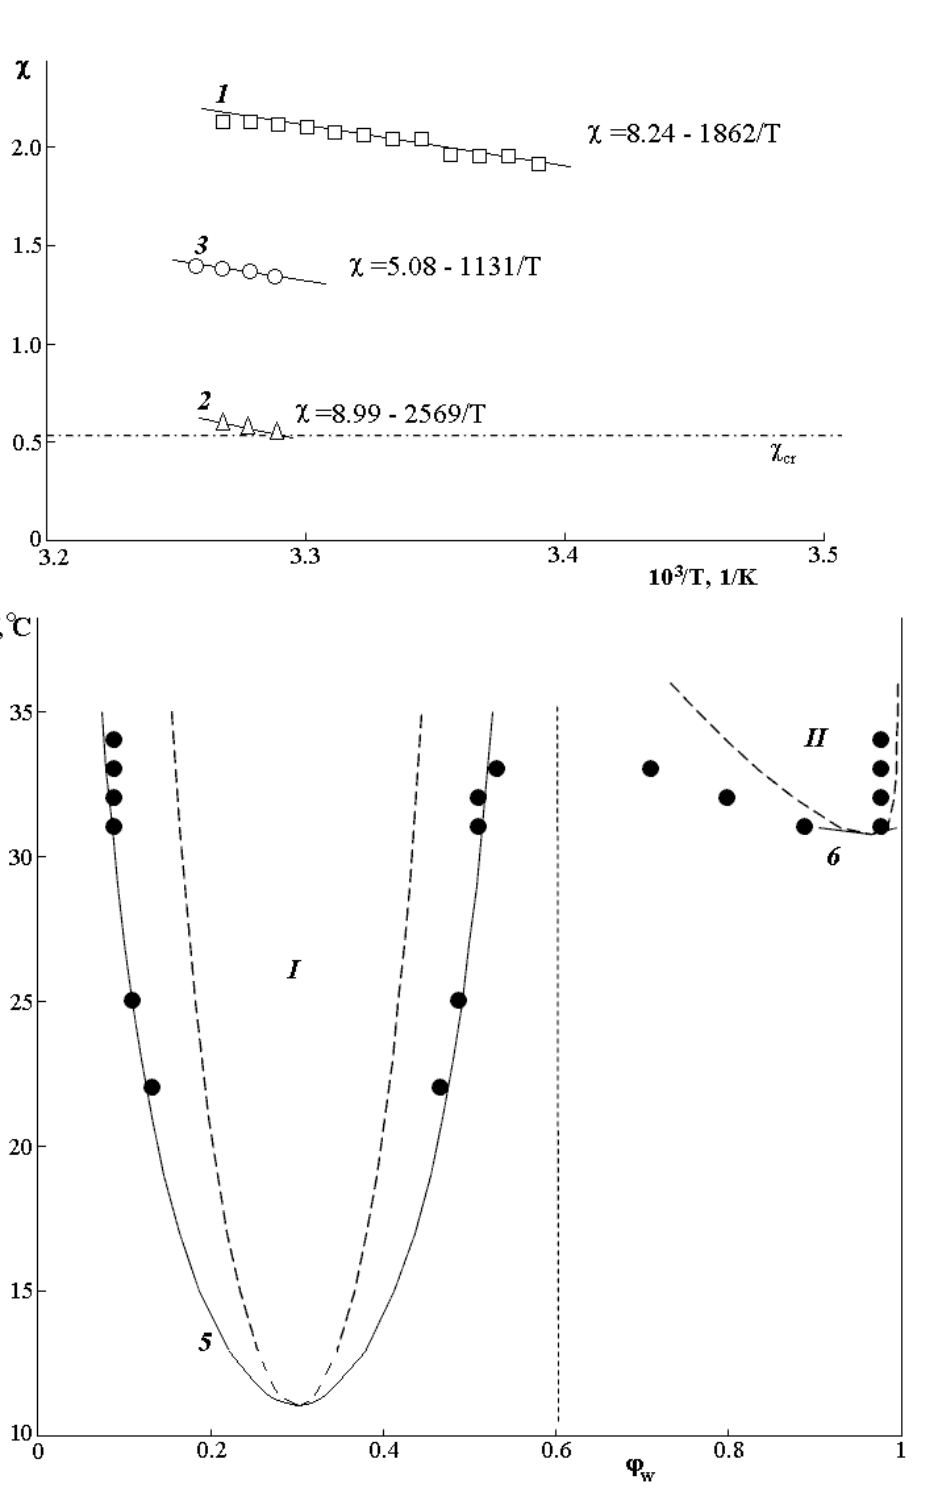
Figure 4. ( a ) Temperature dependence of χ , according to phase separation in I (1), II (2), and III (3) zones and ( b ) simulation of the phase state diagram. The dash-dotted line (4) shows the calculated value of χ cr , according to the Flory–Huggins theory. 5—phase equilibrium simulation for the PVME-PVME · n H 2 O system according to the χ − 1/ T dependence for zone I, 6—phase equilibrium simulation for the PVME-water system according to the χ − 1/ T dependence for zone II. Black points are experimental data of phase equilibrium.